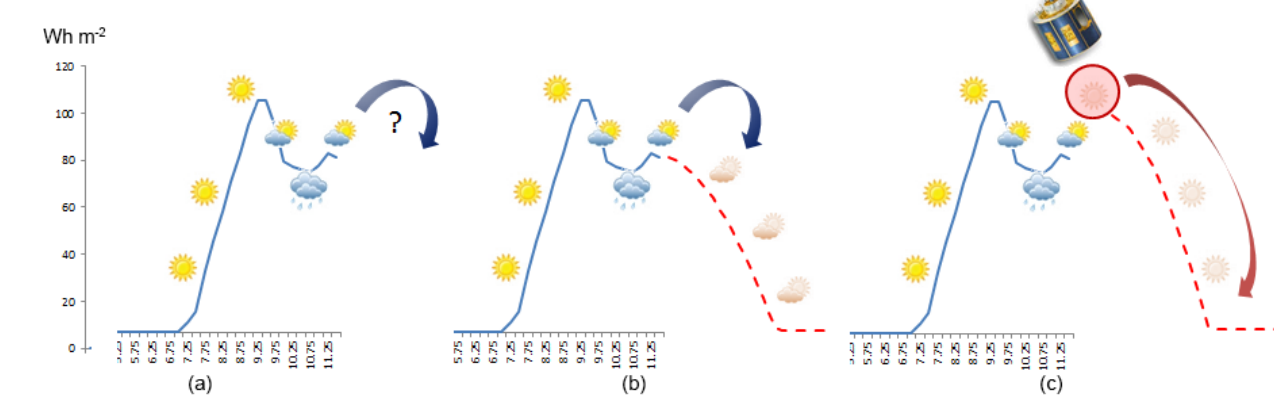
Figure 1. Illustration of the principle of the HC3v4 real-time and short-term forecast